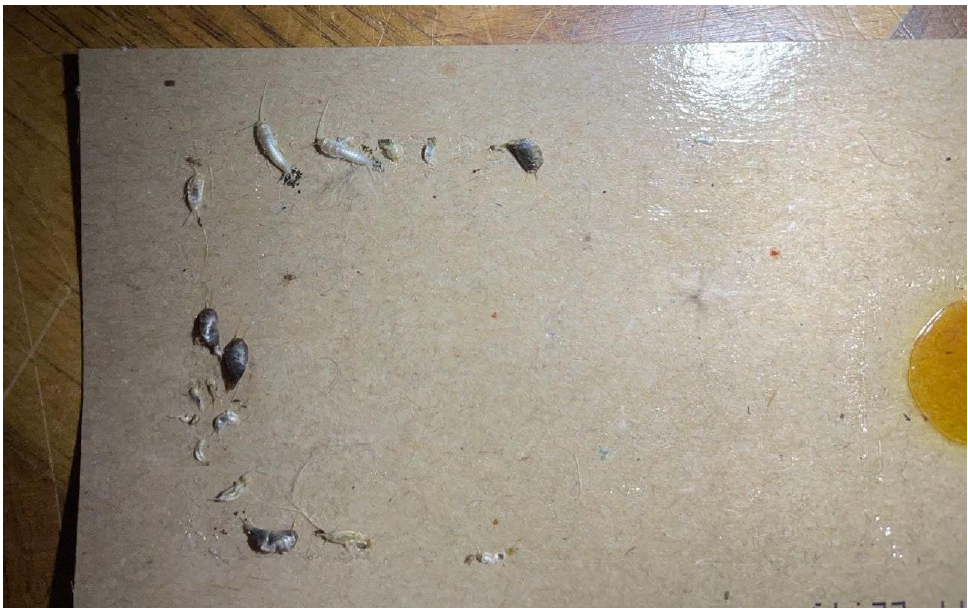
Figure 2. Ctenolepisma calvum, together with Lepisma saccharinum, on a sticky trap in a museum in Vienna, Austria (Photograph: Pascal Querner, Museum of Natural History Vienna).